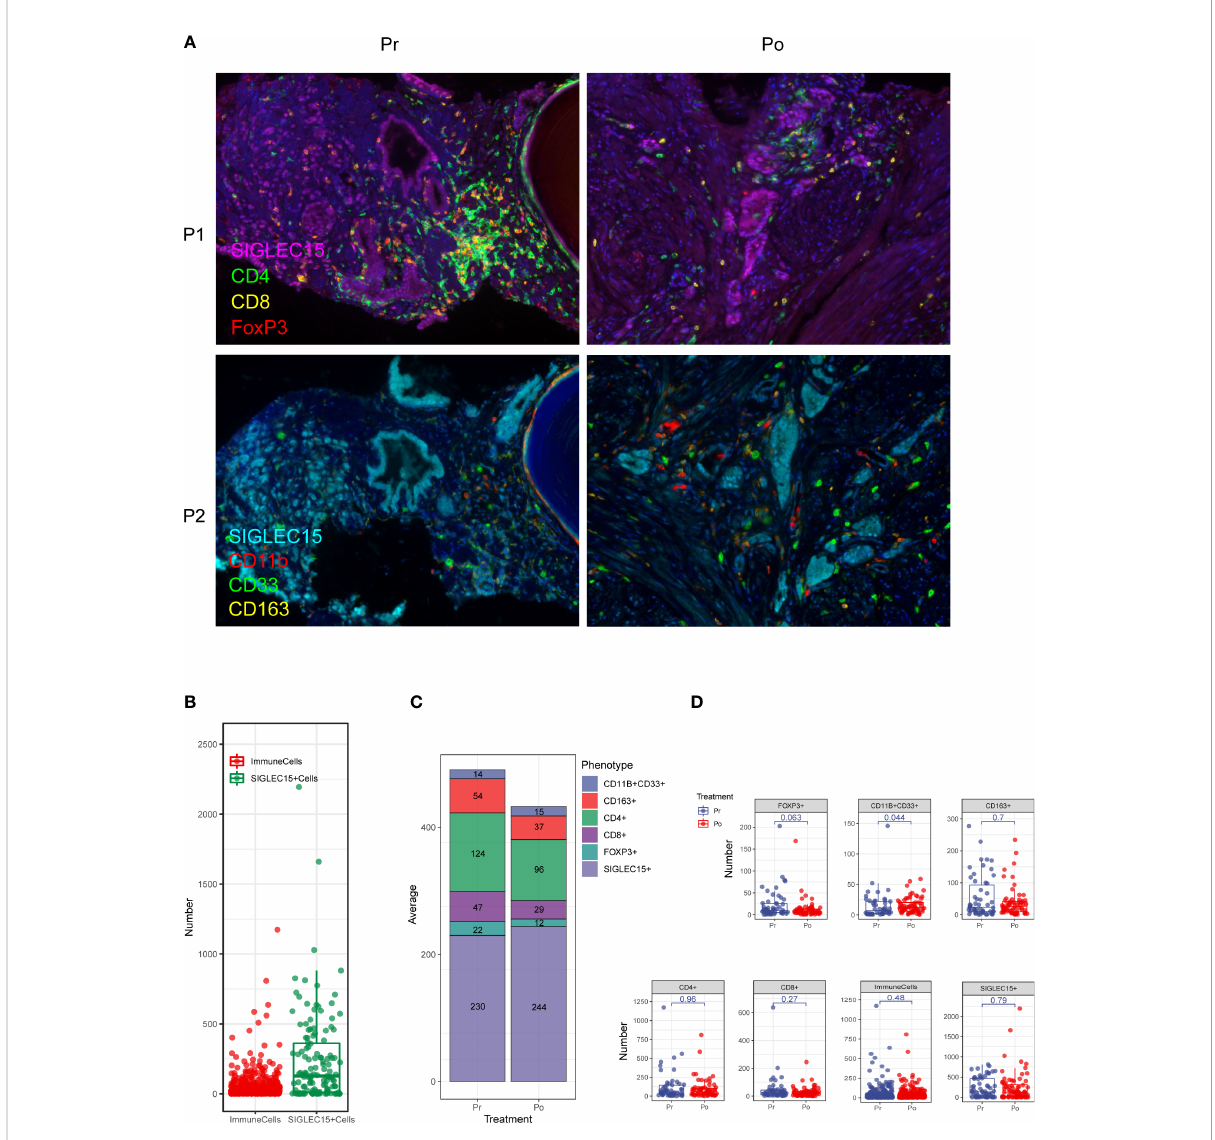
FIGURE 6 Multiplex fl uorescent immunohistochemistry allows phenotyping of 6 unique cell types in the prostate cancer microenvironment. (A) A composite image was created incorporating all of the fl uorophores present in a single tissue slide after multispectral imaging (Pr, pre-ADT; Po, post-ADT; P1, panel 1; P2, panel 2). (B – D) Counts of immune cells and epithelial cells per fi eld. (C) The effect of ADT on the number of every cell